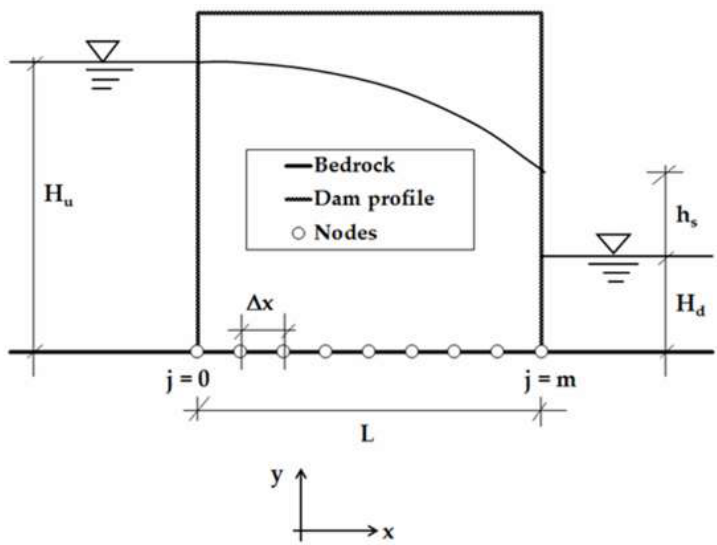
Figure 2. Definition sketch for seepage flow through a dam with vertical upstream and downstream faces.